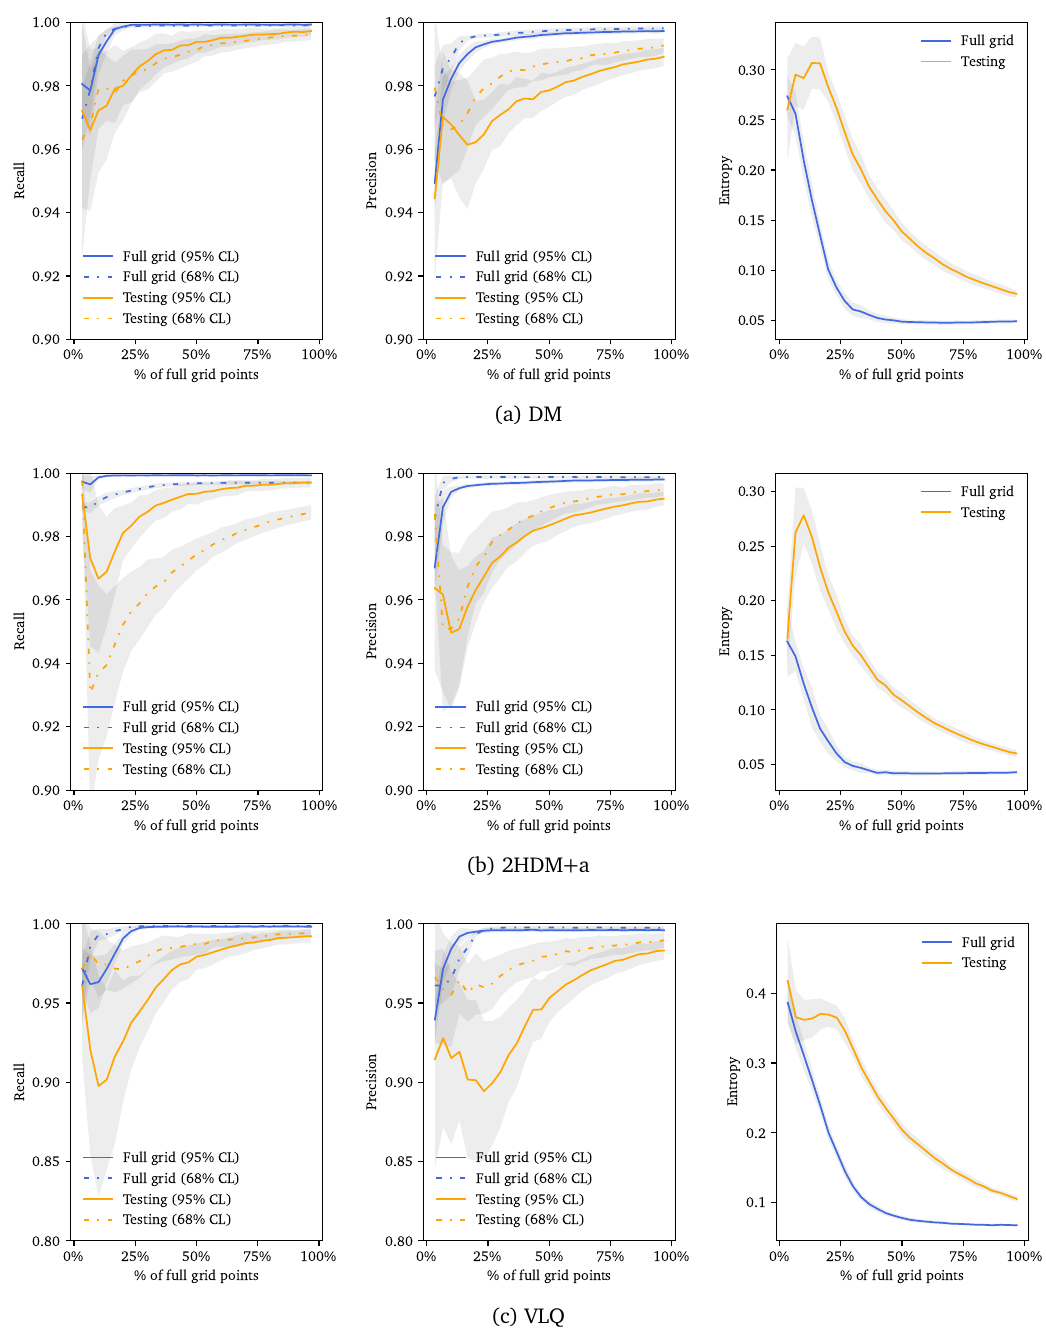
Figure 4: Performance metrics of the C ONTUR O RACLE as a function of fraction of the full-grid points used, for the 95% and 68% CL contours. Given the random nature of the initial sampling, 30 simulations were run; the grey clouds represent the standard deviation. “Full grid” refers to the classifier performance when tested against the “true” exclusion for all the points in the grid (not normally available to the O RACLE unless the full grid was sampled).“Testing” refers to results comparing only to points in the testing